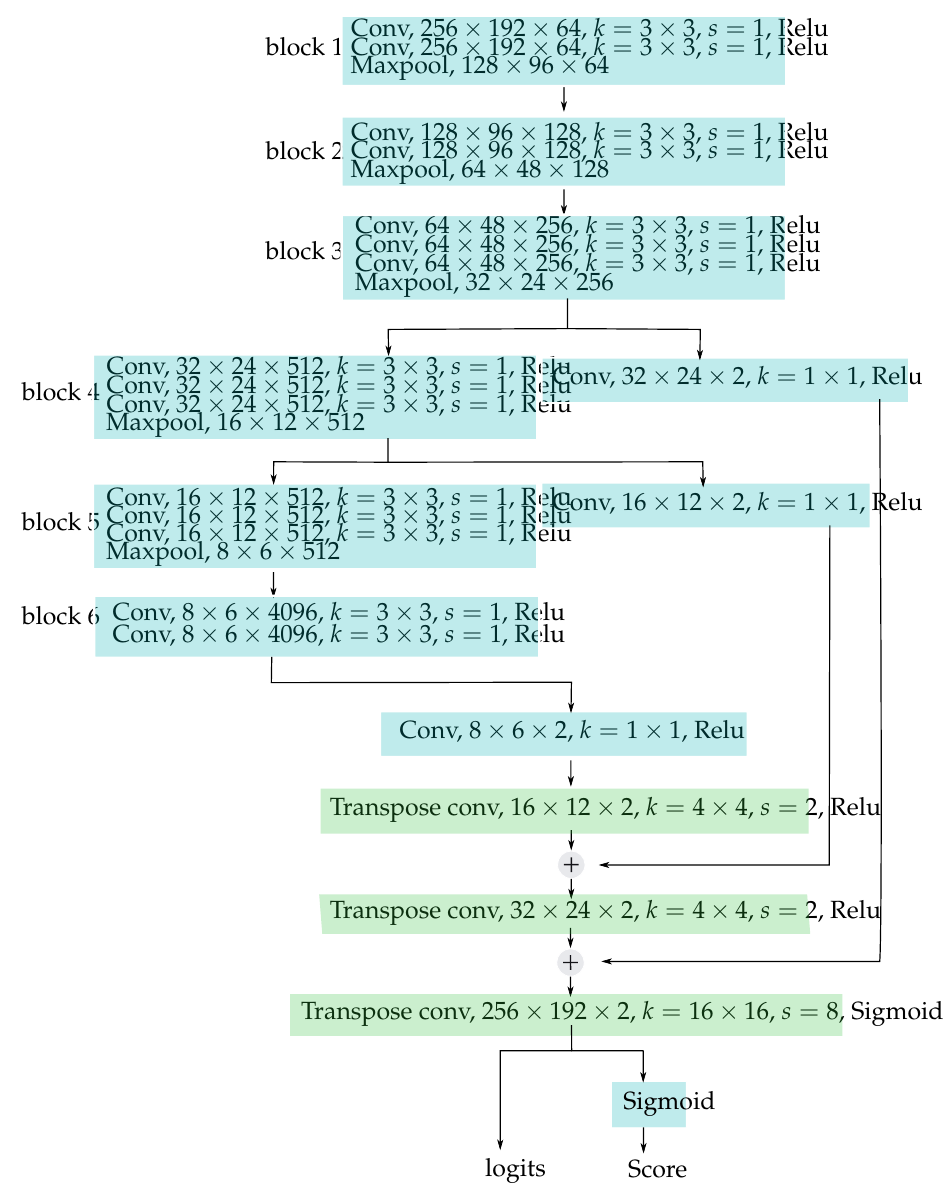
Figure 3. The architecture of the generator. The network has three convolutional layers followed by two fully connected